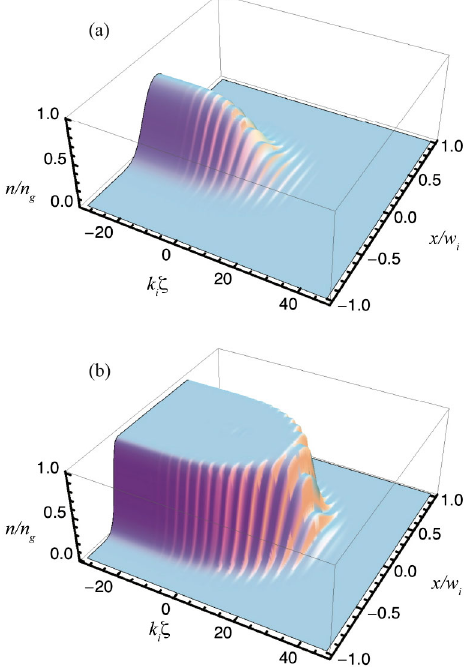
FIG. 5. Fractional ionization n=n ¼ 0 . 2 . The laser field has a wavelength of 0 . 4 μ m and a (b) a i Gaussian longitudinal envelope with length k